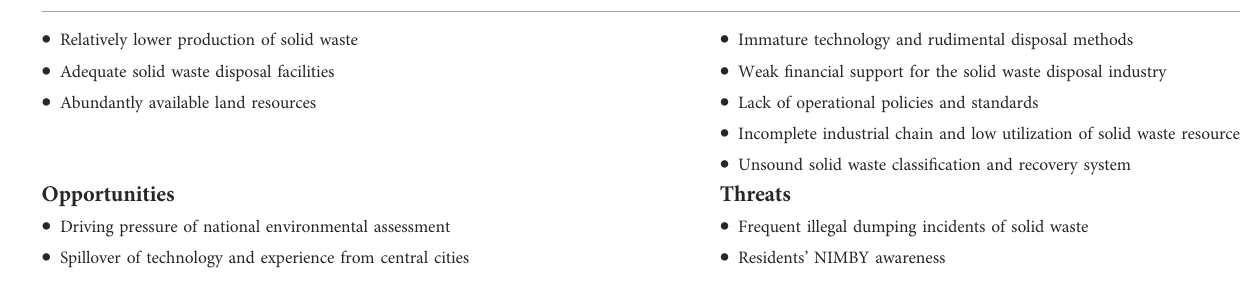
TABLE 2 SWOT analysis of solid waste management in non-central cities.